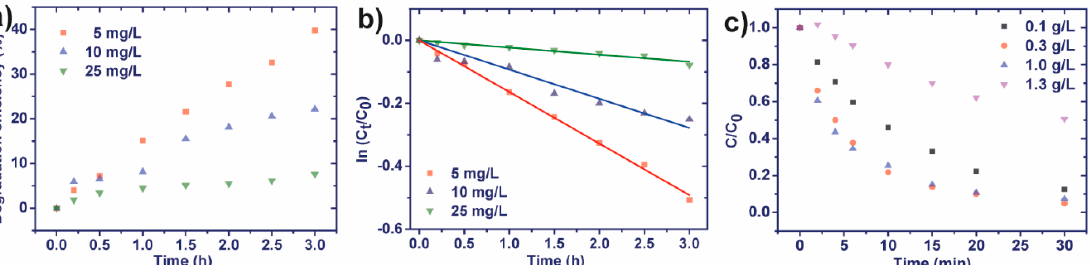
Figure 6. Degradation efficiency (%) ( a ) and ln (C/C0) vs. time ( b ) for different initial ciprofloxacin